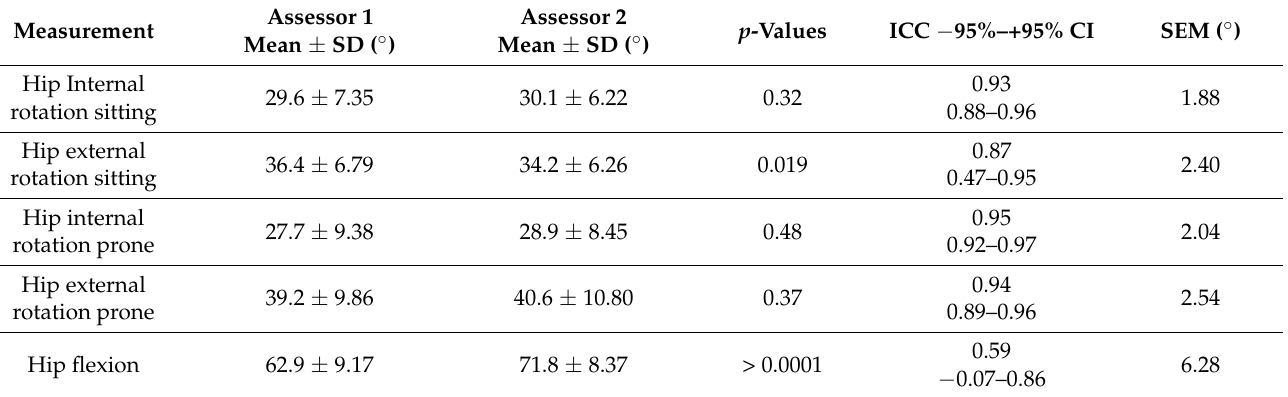
Table 5. Comparison of 2D video analysis measurements from assessor 1 and assessor 2 during home assessment: means ± standard deviations, one way ANOVA p -value, ICC and 95% confidence intervals, and